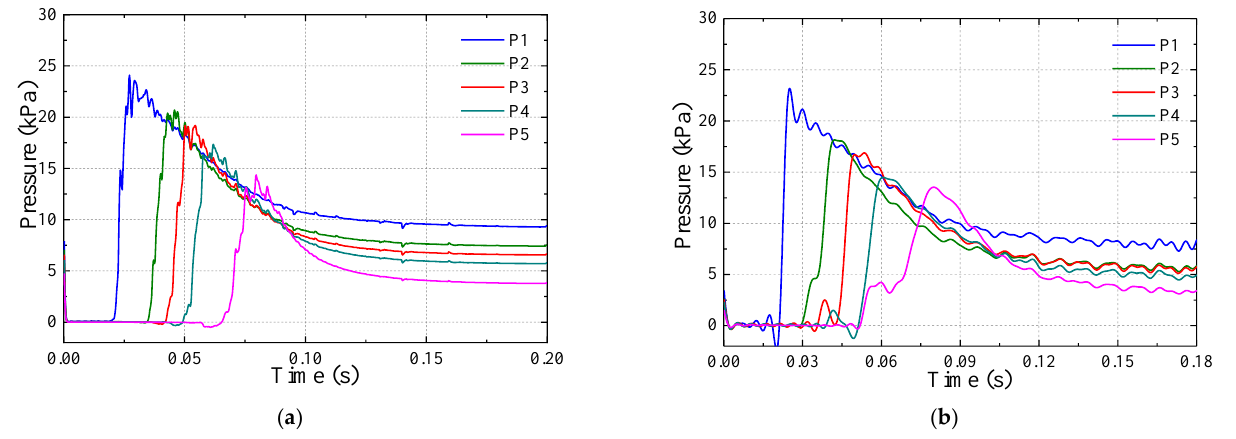
Figure 18. Impact pressure at P1 – 5 by different methods (Case 4): ( a ) numerical results; ( b ) experi- mental results.